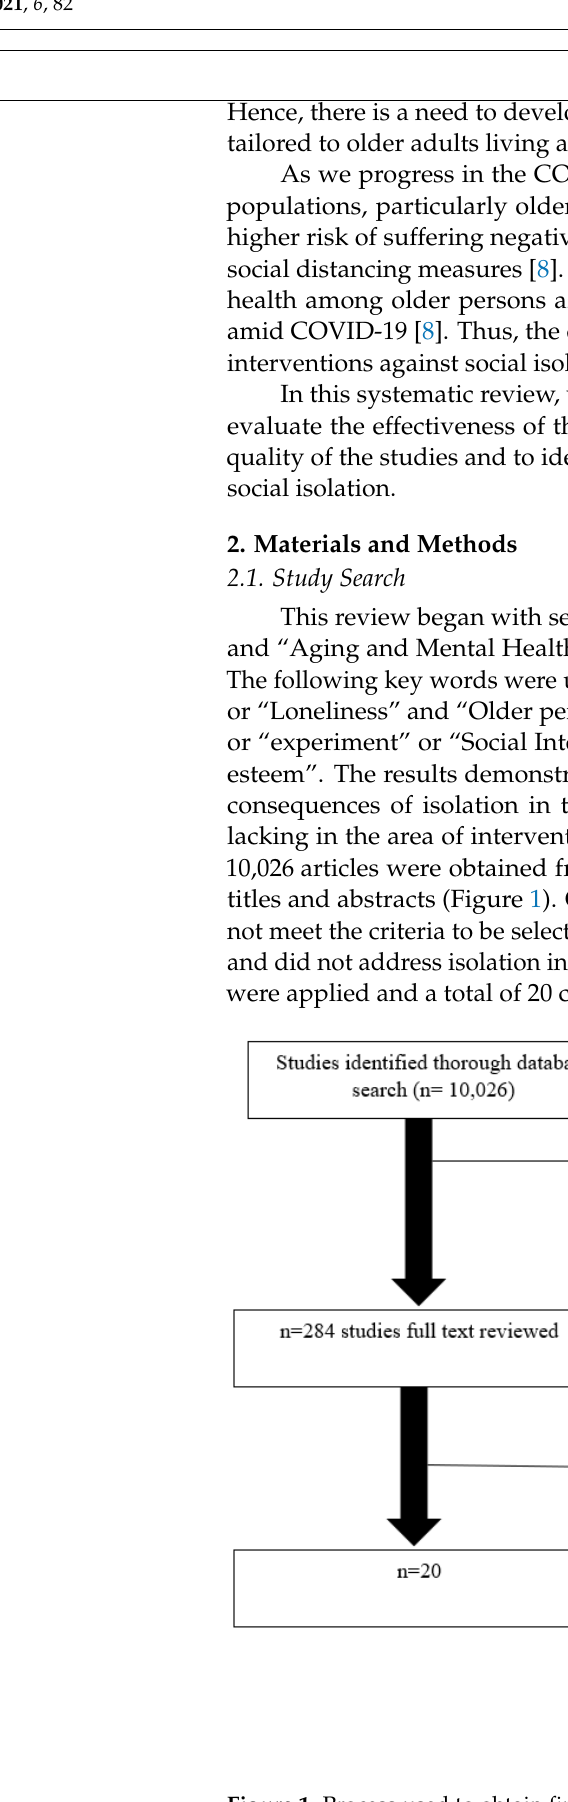
Figure 1. Process used to obtain final articles for analysis.